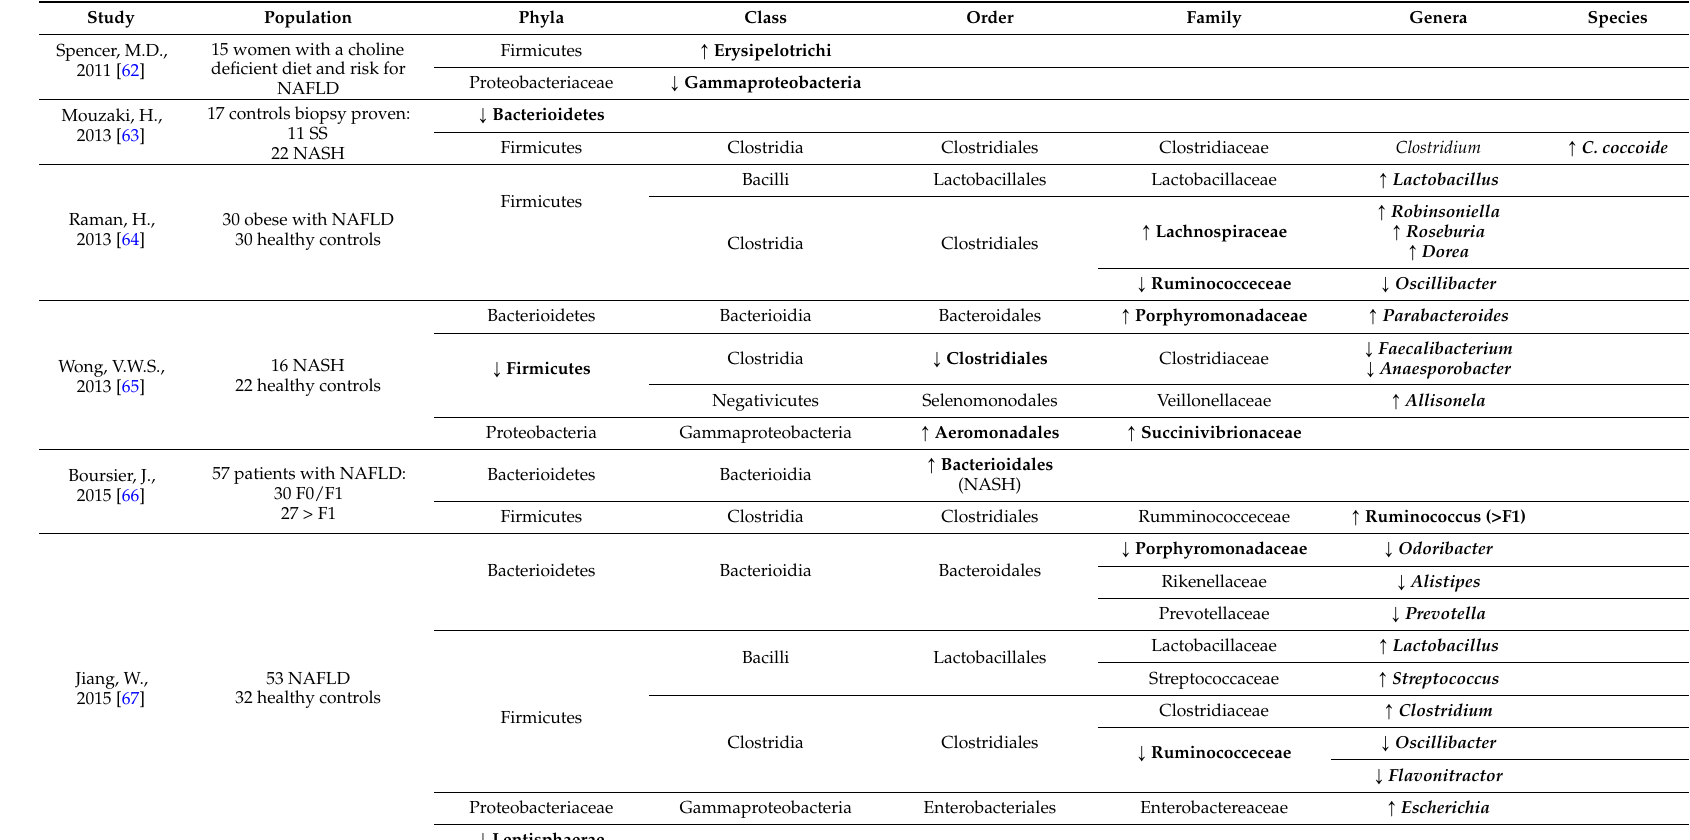
Table 1. Studies evaluating microbiota in human